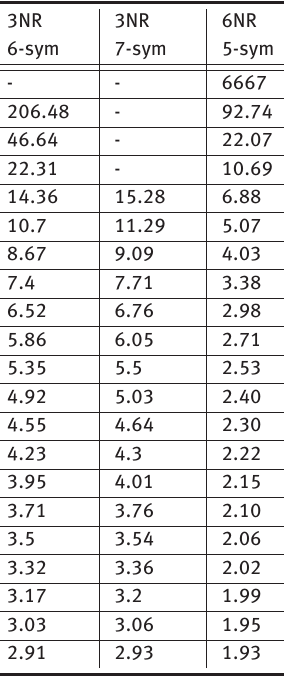
Table 1: Function values at the central